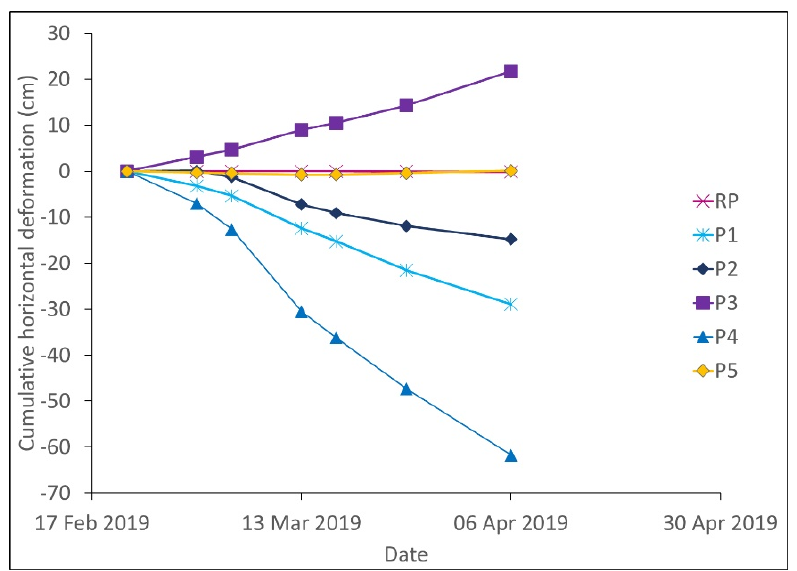
Figure 12. Sentinel-1 InSAR cumulative horizontal deformation (west–east) from combined analyses of ascending (VV polarization) and descending (HH polarization) observations. + for eastward deformation, − for westward deformation.